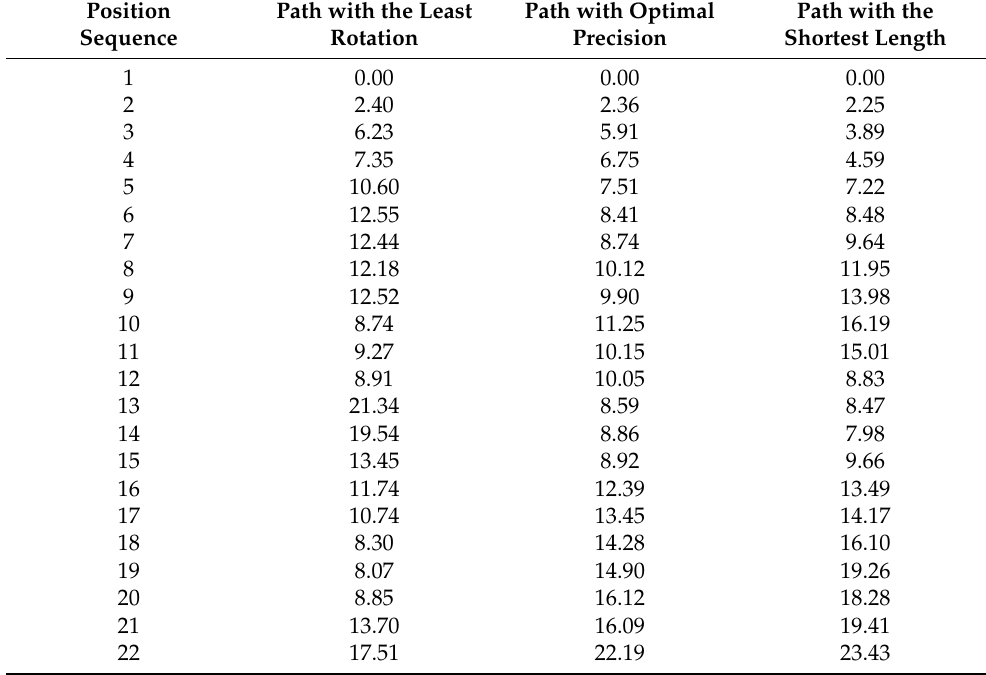
Table 4. Average position error at each target position (mm).